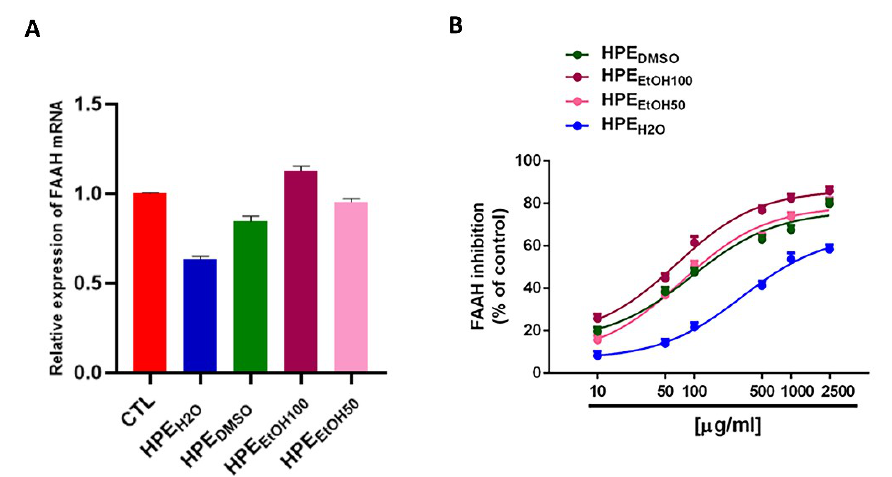
Table 4. IC 50 values of Harpagophytum procumbens root extract (HPE) dissolved in DMSO (HPE DMSO ), 100% v / v EtOH (HPE EtOH100 ), 50% v / v EtOH (HPE EtOH50 ), and deionized water (HPE H2O ) and the positive control JZL 195 in the FAAH inhibition assay.